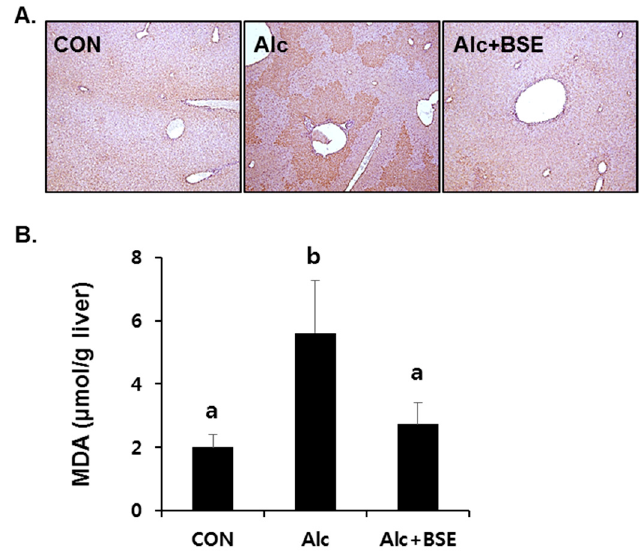
Figure 3. Lipid peroxidation in the livers of alcohol-fed mice with or without barley sprout extract (BSE) for 4 weeks. ( A ) Immunohistochemistry of 4-HNE in the liver tissue and ( B ) malondialdehyde (MDA) level in the liver homogenate. Each value is presented as mean ± SD of 6 mice. Values with different letters are significantly different by analysis of variance (ANOVA) followed by Newman–Keuls multiple comparisons test ( p < 0.05). CON, control diet-fed mice; Alc, alcoholic diet-fed mice; Alc+BSE, alcoholic diet-fed mice treated with barley sprout extract (100 mg/kg).